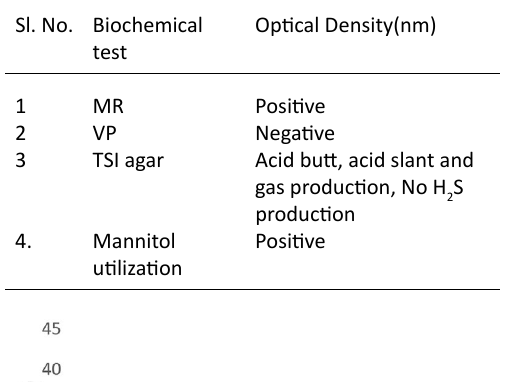
Table 1. Biochemical testing of isolated organism Sl. No. Biochemical